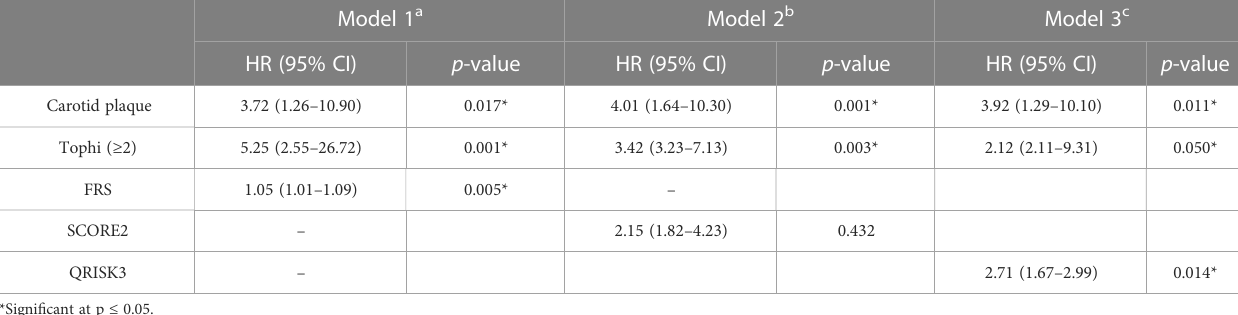
TABLE 4 Multivariable Cox regression model for predicting MACE (n=240).